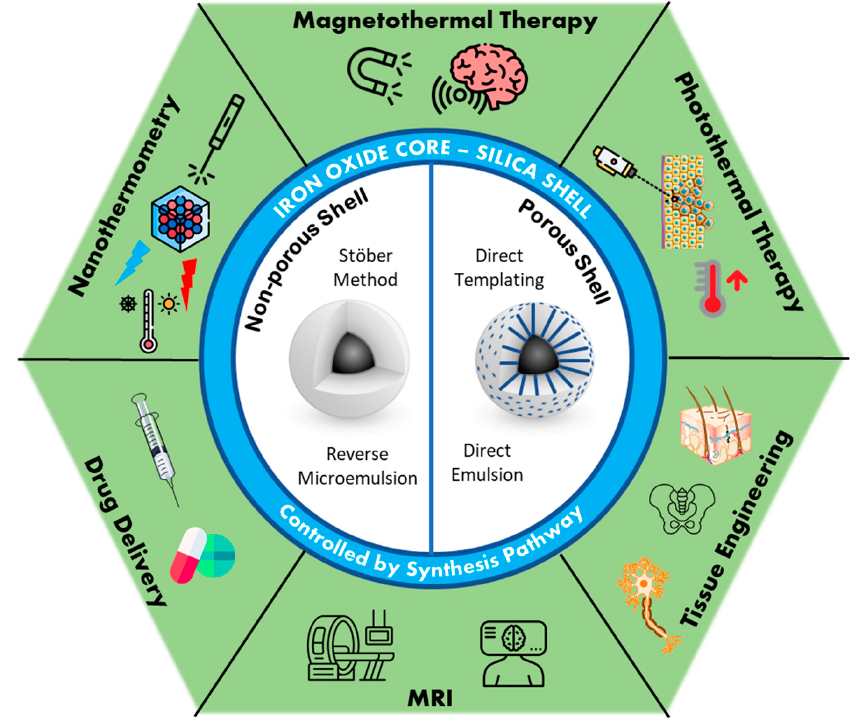
Figure 1. Scheme illustrating the strategies for the design of iron oxide core @silica shell nanomaterials and their potential application for magneto and photothermal therapy hyperthermia, MRI, tissue engineering, nanothermometry, or drug delivery.